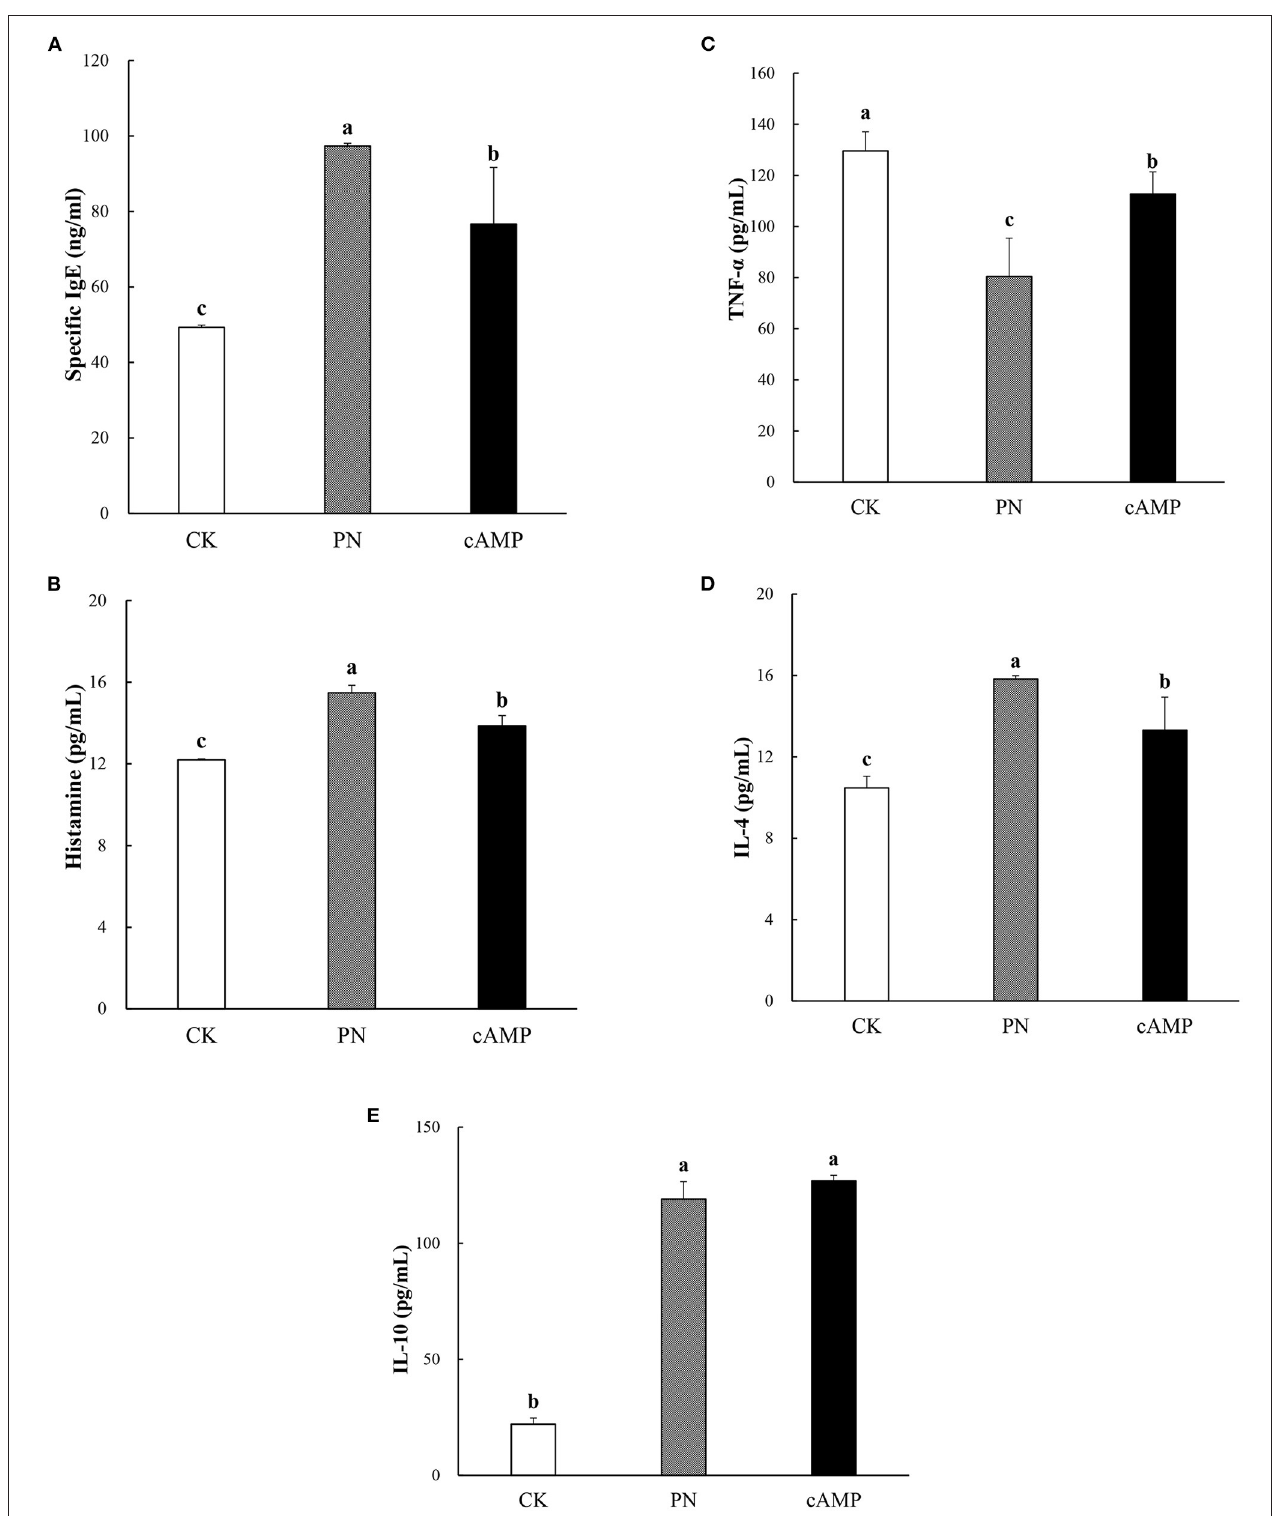
FIGURE 6 | Effect of oral administration with cAMP on serum-specific immunoglobulin (IgE) (A) , histamine (B) , tumor necrosis factor- α (TNF- α ) (C) , interleukin-4 (IL-4) (D) , and interleukin-10 (IL-10) (E) levels in PN-sensitized mice. The levels of these biological markers were measured by ELISA after repeated oral administration of cAMP. Data are expressed as the means ± SDs. Different lowercase letters represent mean significant difference ( p < 0.05) between the groups of mice.